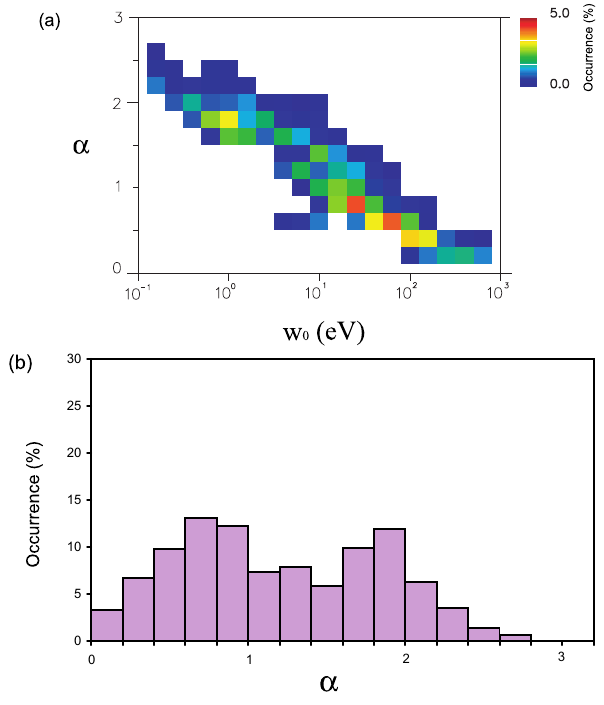
Fig. 10. (a) Occurrence distributions P(w 0 ,α) of the parameters associated with the heating profile versus altitude, and (b) the same distribution P(α ) integrated over w 0